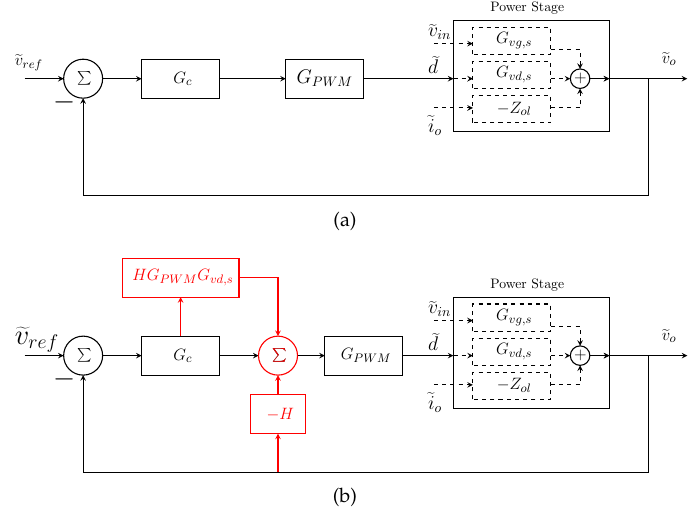
Figure 3. The block diagram of ( a ) the conventional controller; and ( b ) the modified controller emphasizing the modifications in red. PWM: pulse-width